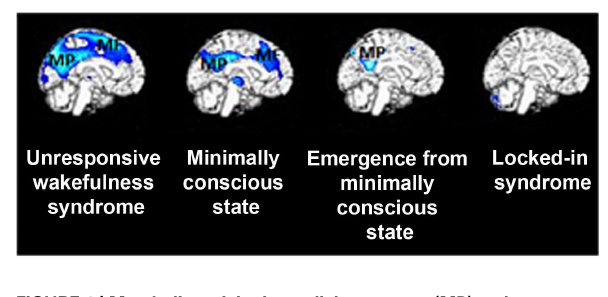
FIGURE 1 | Metabolic activity in medial precuneus (MP) and mesiofrontal (MF) cortex is severely impaired in patients with disorders of consciousness, such as in vegetative state/unresponsive wakefulness syndrome and minimally conscious state . Of note is that patients who have emerged from the minimally conscious state (who yet experience confusion and amnesia syndromes) show metabolic dysfunction only in the posterior cingulate and adjacent retrosplenial cortex but not in the lateral frontoparietal network (see text). Finally, fully conscious yet severely paralyzed patients with locked-in syndrome do not show metabolic impairment in any of these areas, suggesting a critical involvement of midline regions in supporting self-related cognition (figure adapted fromThibaut et al.,